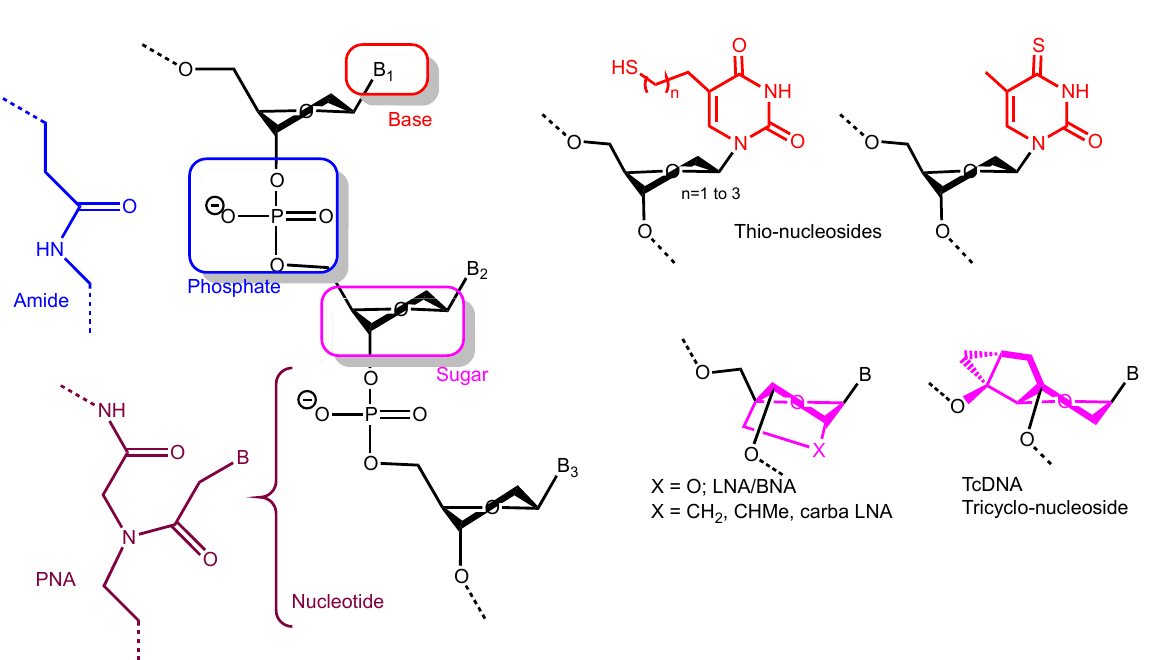
Figure 3. Examples of nucleoside analogues used to constrain nucleic acids structures.